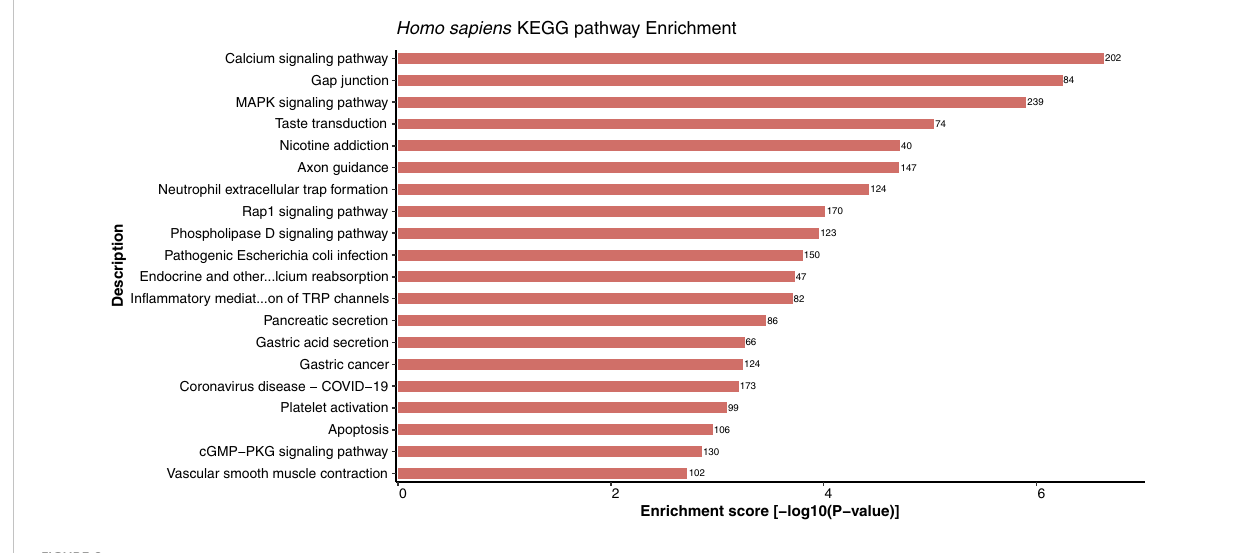
FIGURE 8 Depiction of signi fi cantly enriched pathways for human proteins involved in interactions with monkeypox virus proteins, based on enrichment